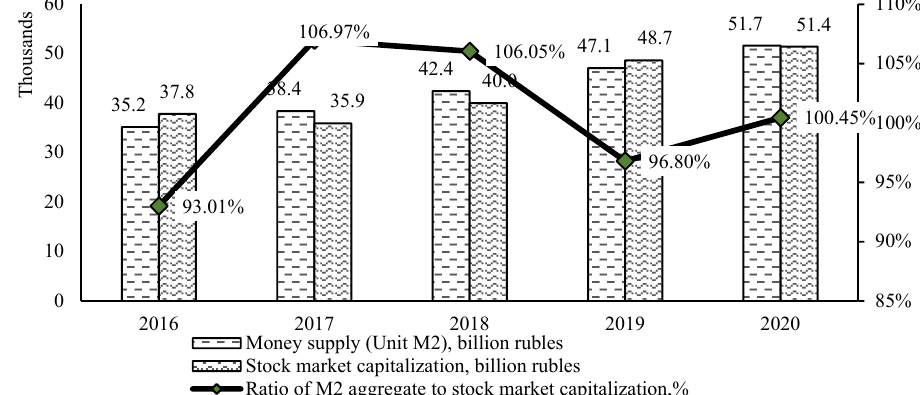
Figure 2. Dynamics of the indicator “ratio of the M2 aggregate to the capitalization of the stock